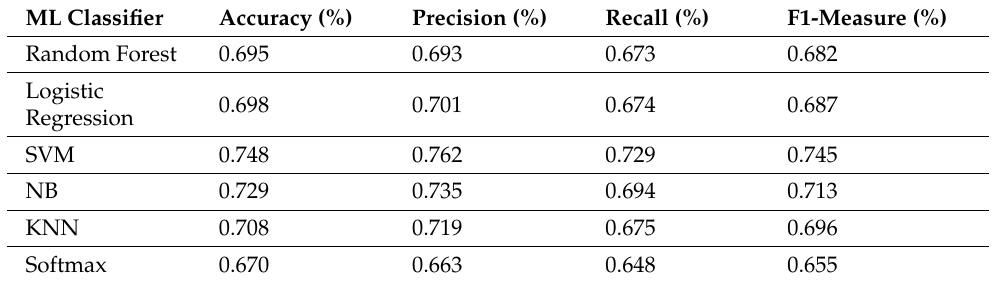
Table 4. Roman Urdu CNN-LSTM performance with various ML classifiers using RUSA-19 corpus.